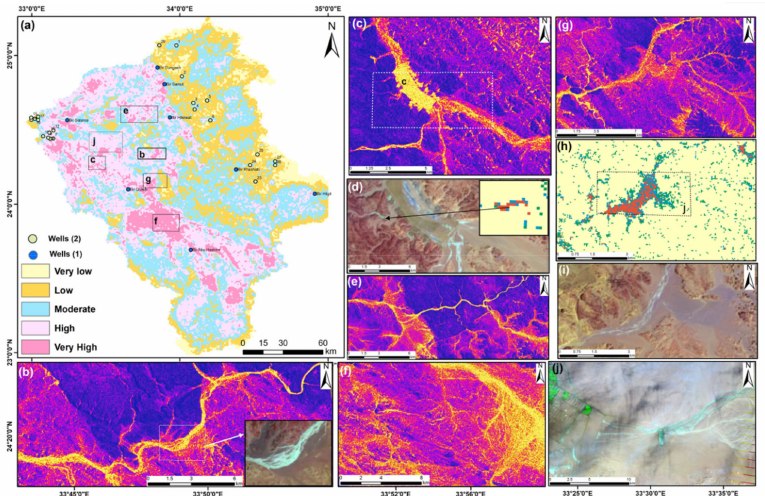
Figure 13. ( a ) Groundwater recharge potential map overlaid by water wells, quoted from [55] (Well 1) and [56] (Well 2); ( b ) subset of InSAR coherence map reveals the change in land-cover along wadis as a result of runoff, and Landsat-8 images reveal agricultural activities; ( c , d ) InSAR CCD image provides evidence of water accumulation as indicated by the Landsat image in (d) following the rainfall storm, which is consistent with the active stream (yellow); ( e ) InSAR CCD reveals active streams of W. Shait that receive runoff during storms as well as ( f ) W. Garara; ( g , h ) InSAR CCD image reveals changes along the mainstream that are consistent with the extracted depression. Landsat image in ( i ) depicts the existence of an active stream in bright tone. ( j ) Evidence of water accumulation downstream of W.